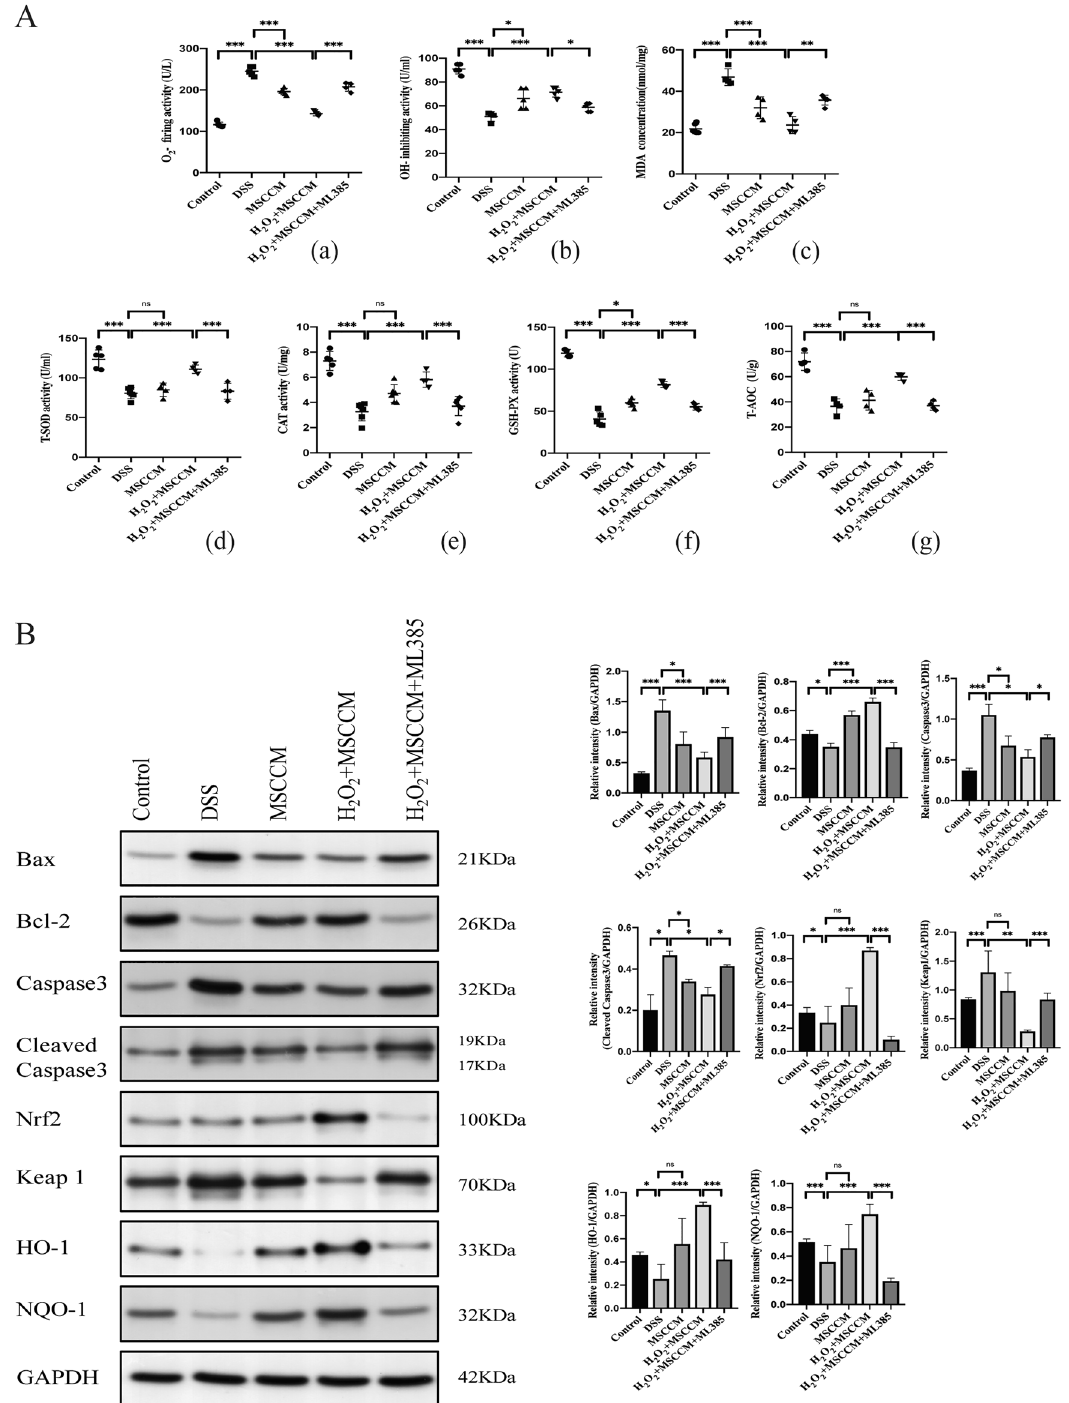
Figure 7. H 2 O 2 pretreated MSC-CM exhibits anti-oxidant and anti-apoptosis activities in colon tissue. ( A ) The quantitative evaluation of oxidative stress in colon homogenate including O 2− (a), OH − (b), and MDA (c). The indexes of the enzyme antioxidant system including SOD (d), CAT (e), GSH-Px (f), and T-AOC (g). ( B ) Immunoblotting assay determined the abundance of Bax, Bcl-2, Caspase 3, Cleaved Caspase3, Nrf2, Keap1, HO-1, and NQO-1 proteins. Semiquantitative analysis of proteins of interest by densitometry assay. The data are expressed as the mean ± SD. * P < 0.05, ** P < 0.01, and *** P < 0.001; ns no